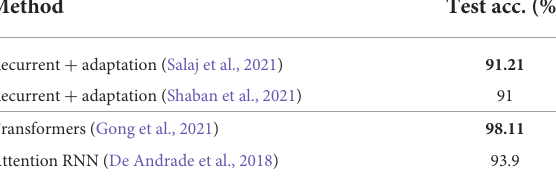
TABLE 4 State-of-the-art on the SC dataset (version 2 with 35 labels).